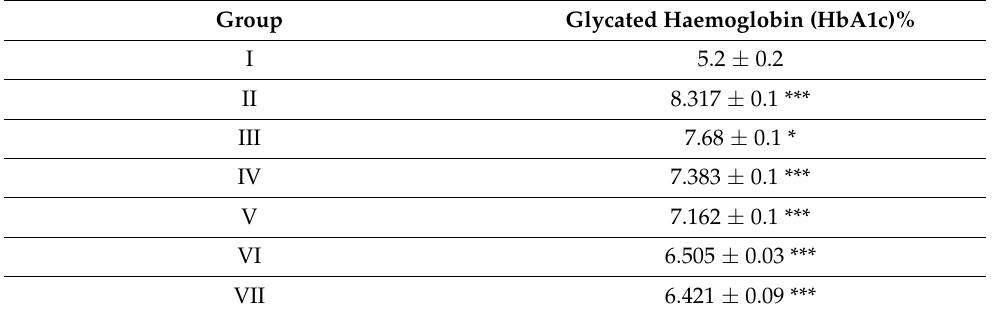
Table 6. In STZ-induced diabetic rats, the effects of TPE, TPZnO NPs, and glibenclamide on glycated hemoglobin. Group